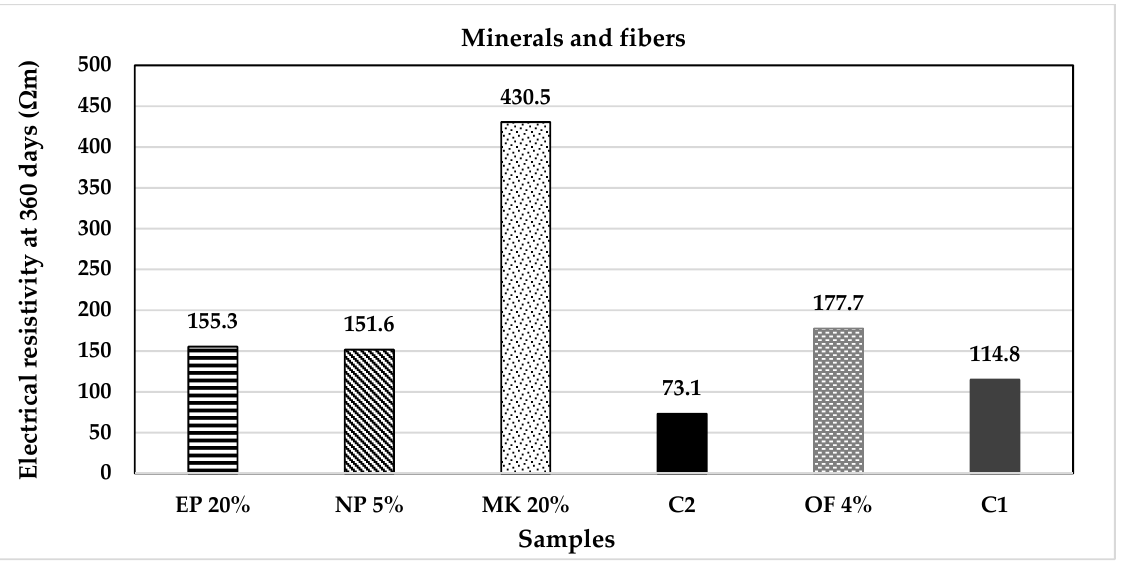
Figure 17. Electrical resistivity of the agricultural and industrial wastes group of additions.